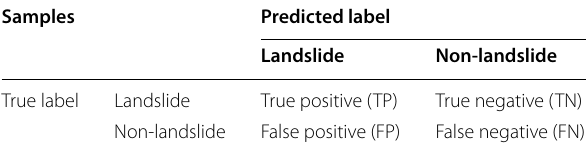
Table 3 Discriminant matrix of statistical indexes Samples Predicted label